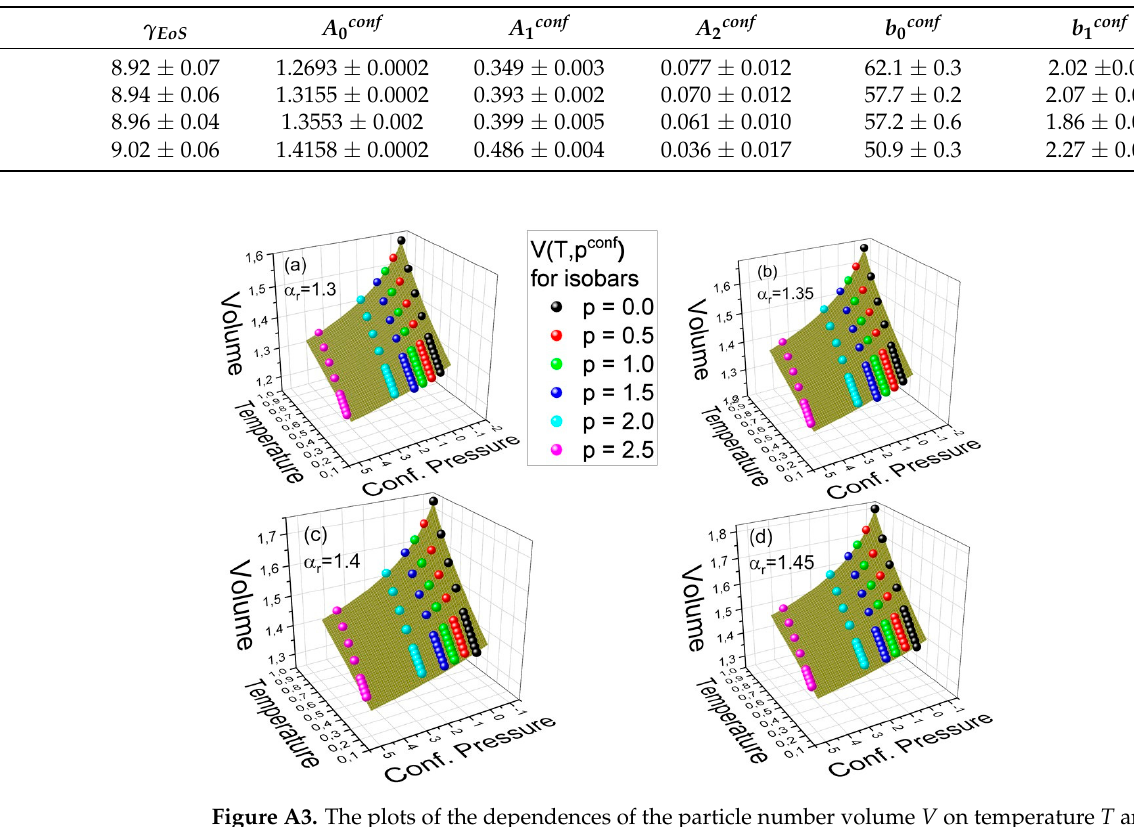
Table A1. The values of the fitting parameters of Equation (A1) established for all examined anisotropy aspect ratios in the supercooled liquid state in the GB model. The determination er- rors of the values of the EoS parameters are estimated as the standard deviation errors found from fitting all pVT simulation data to Equation (A1) for a given anisotropy aspect ratio.